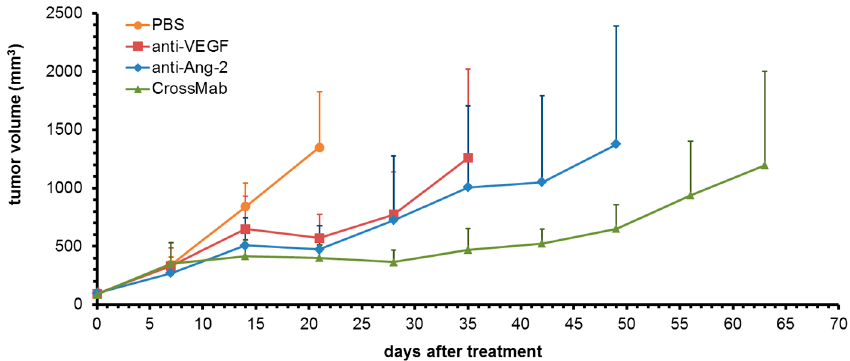
Figure 1. Analysis of tumor growth inhibition comparing single- vs. co-targeting VEGF and Ang-2. Mice were treated once weekly starting on day 0. Values are means of tumor volumes ± standard deviation ( n = 3).